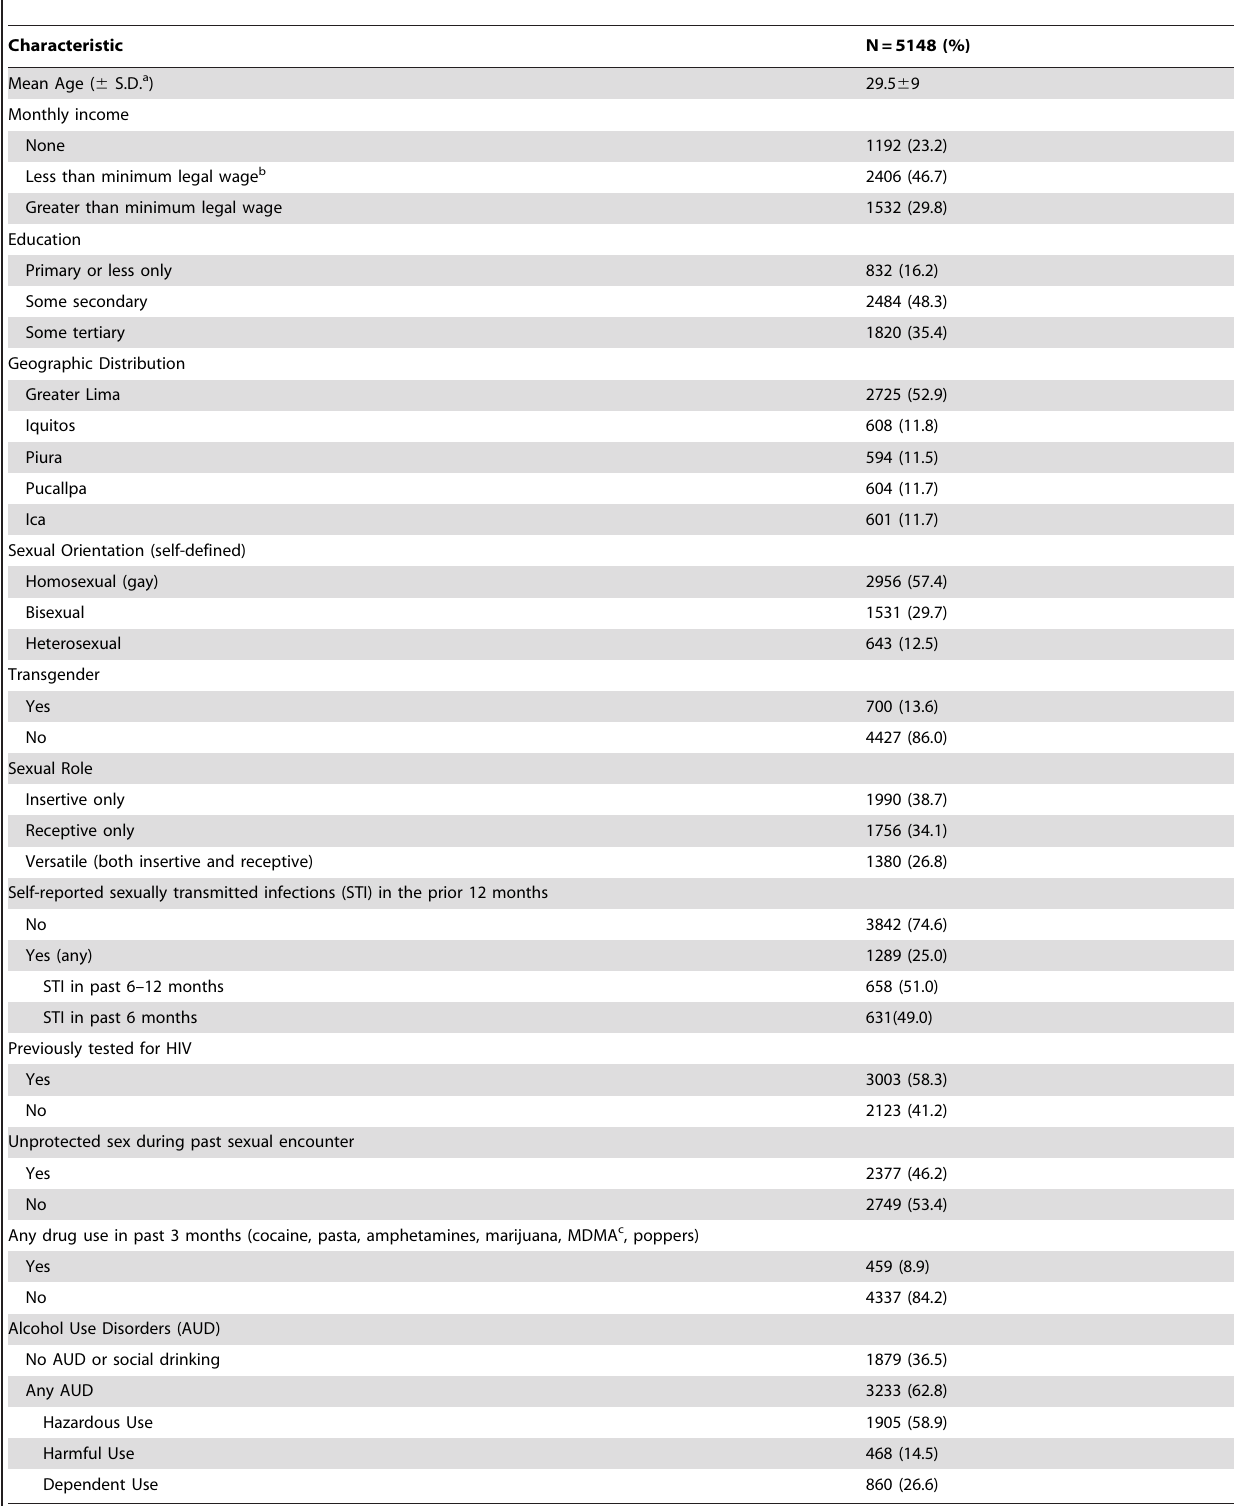
Table 1. Sociodemographic, alcohol use and sexual behavioral characteristics of the study sample (N =5148).